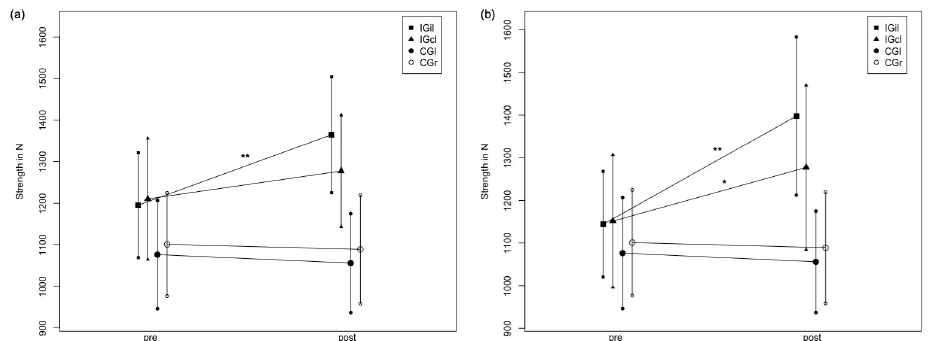
Figure 4. Illustrating the mean value curve of the maximum strength values in IG1il, IG1cl and both groups of CG (CGl and CGr) ( a ) as well as the mean value curve of the maximum strength values in IG2il, IG2cl and both groups of CG ( b ). ** = p < 0.001, * = p < 0.05 for difference to control group . Post-hoc analysis for F-tests of G-Power were calculated as 1 − β = 42.00% for the lowest effect size with ƞ 2 = 0.123, and 1 − β = 99.99% for the highest effect size with ƞ 2 =